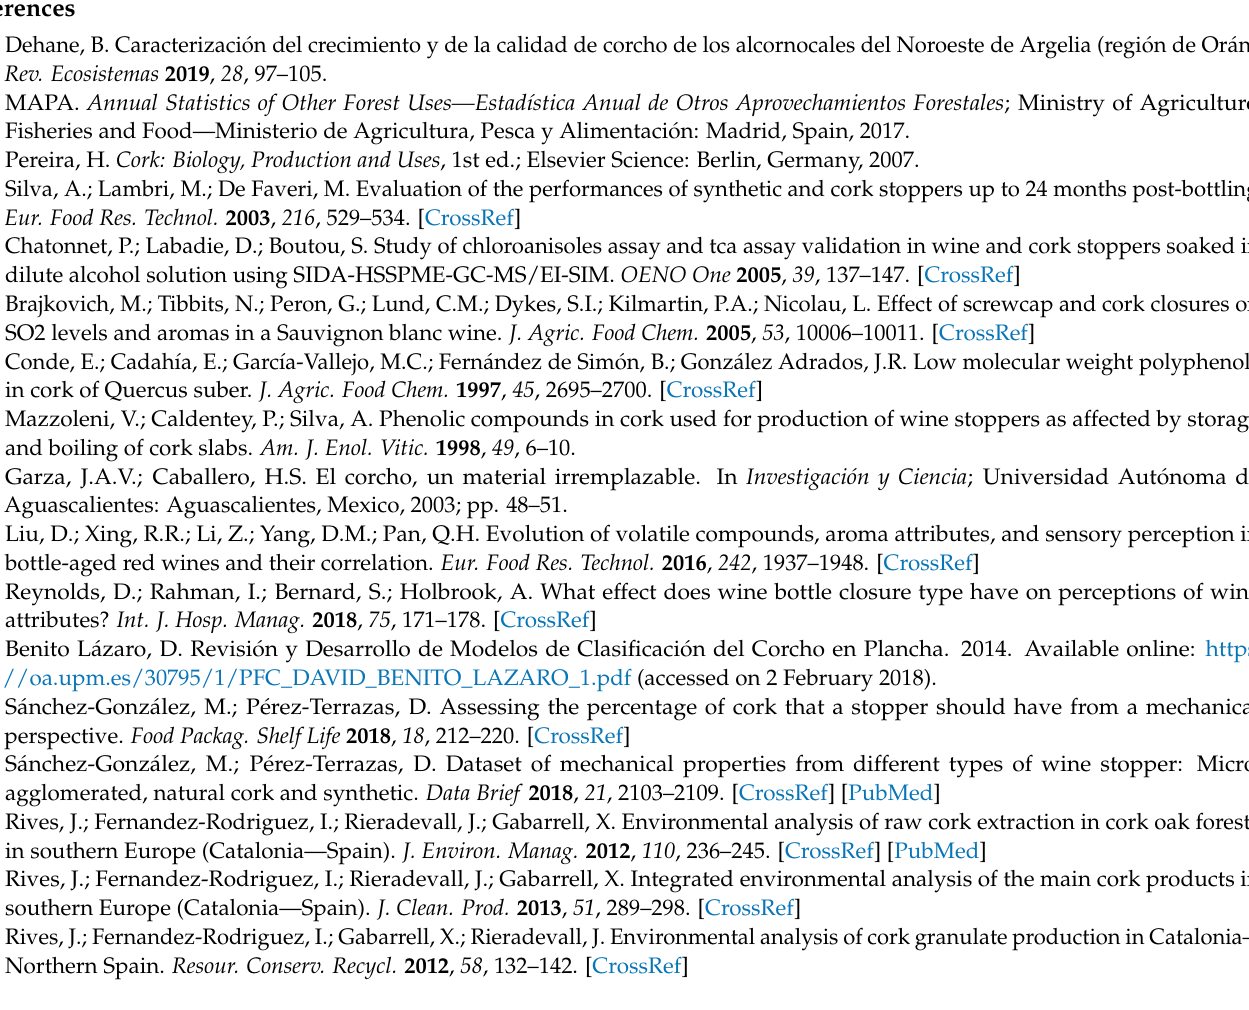
Table S2: Distribution of global environmental impact per kg of natural cork stopper, CML and punched methodologies; Table S3: Distribution of global environmental impact per kg of natural cork stopper, CML and turned